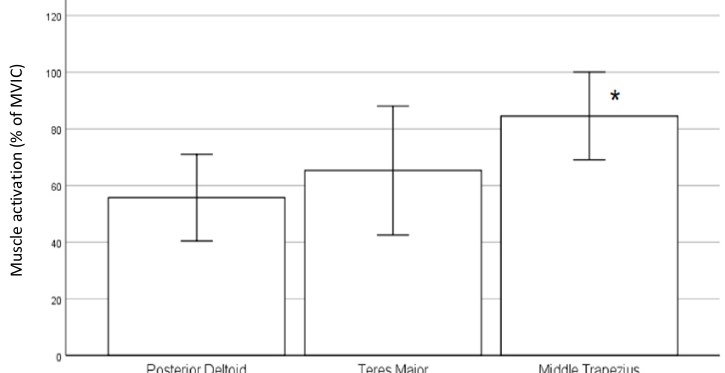
Figure 4. Muscle activity in initial phase (in % of MVIC). * Significantly higher muscle activation of middle trapezius compared to posterior deltoid ( p < 0.05).